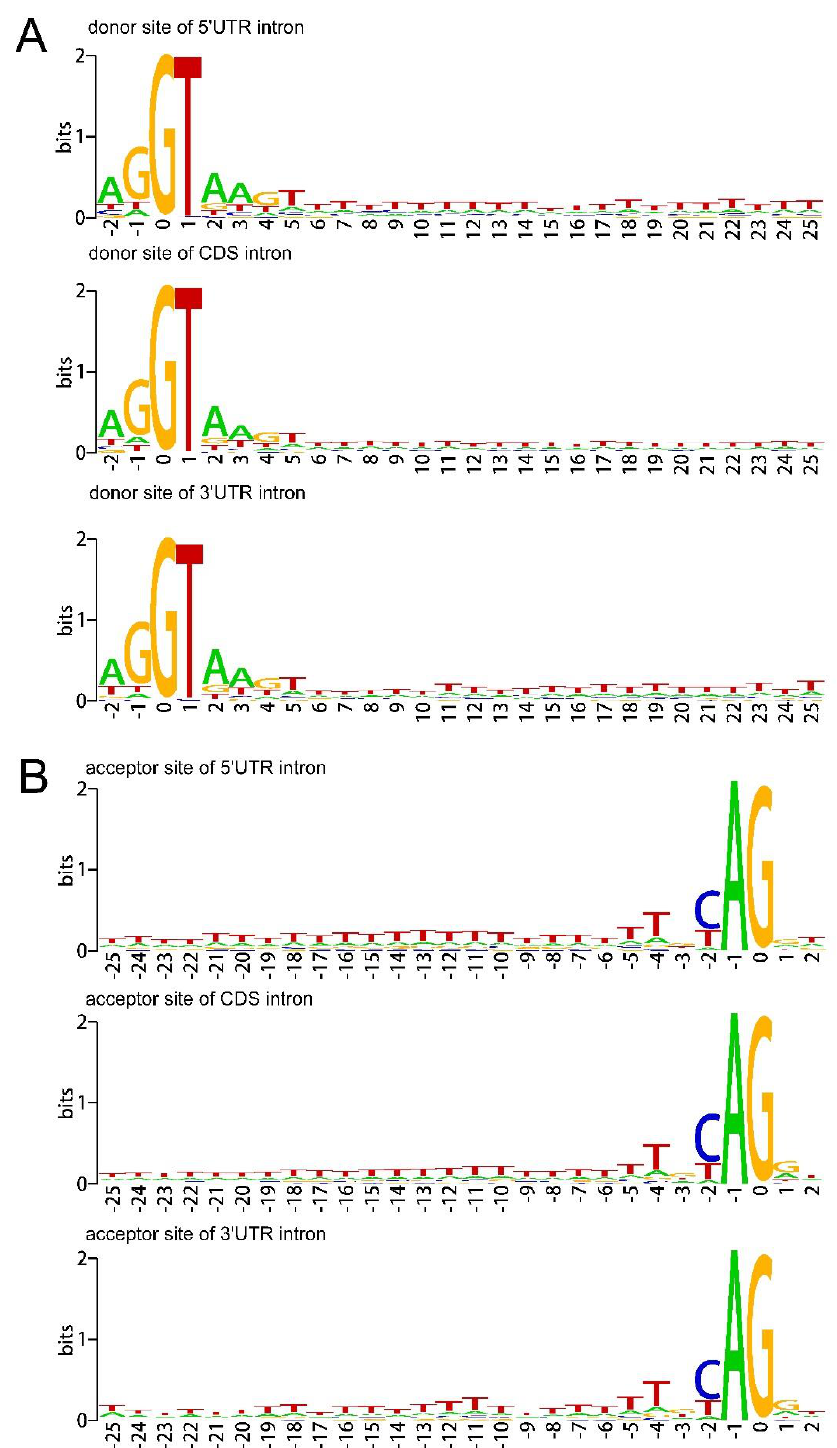
Figure 3. Sequence logos showing the nucleotide bias around the donor site ( A ) and acceptor site ( B ) of 5’UTR, CDS, and 3’UTR introns. The sequence marker shows the nucleotide deviation around the donor site and acceptor site of the 5’UTR, CDS, and 3’UTR introns. The x-axis refers to the base at the beginning of the intron, and the letter height reflects the nucleotide deviation at each position. Only 5 nucleotide exons and 25 nucleotide intron sequences of the donor site and only 2 nucleotide exons and 25 nucleotide intron sequences of the acceptor site are included in the sequence identifier, because the nucleotide usage outside of these regions is not significantly di ff erent from the background